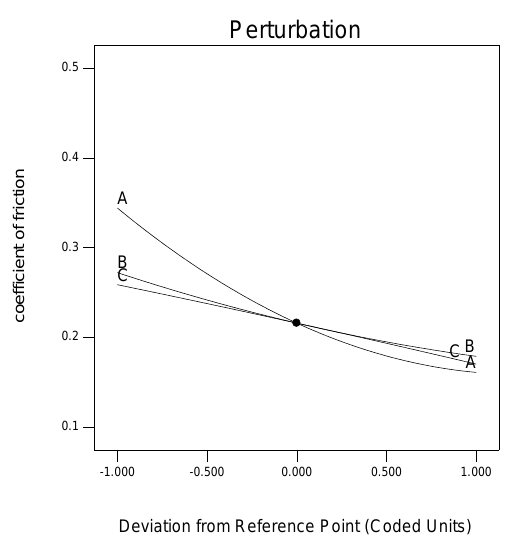
Figure 7. Perturbation plot of the process control variables’ effects on the coefficient of friction.